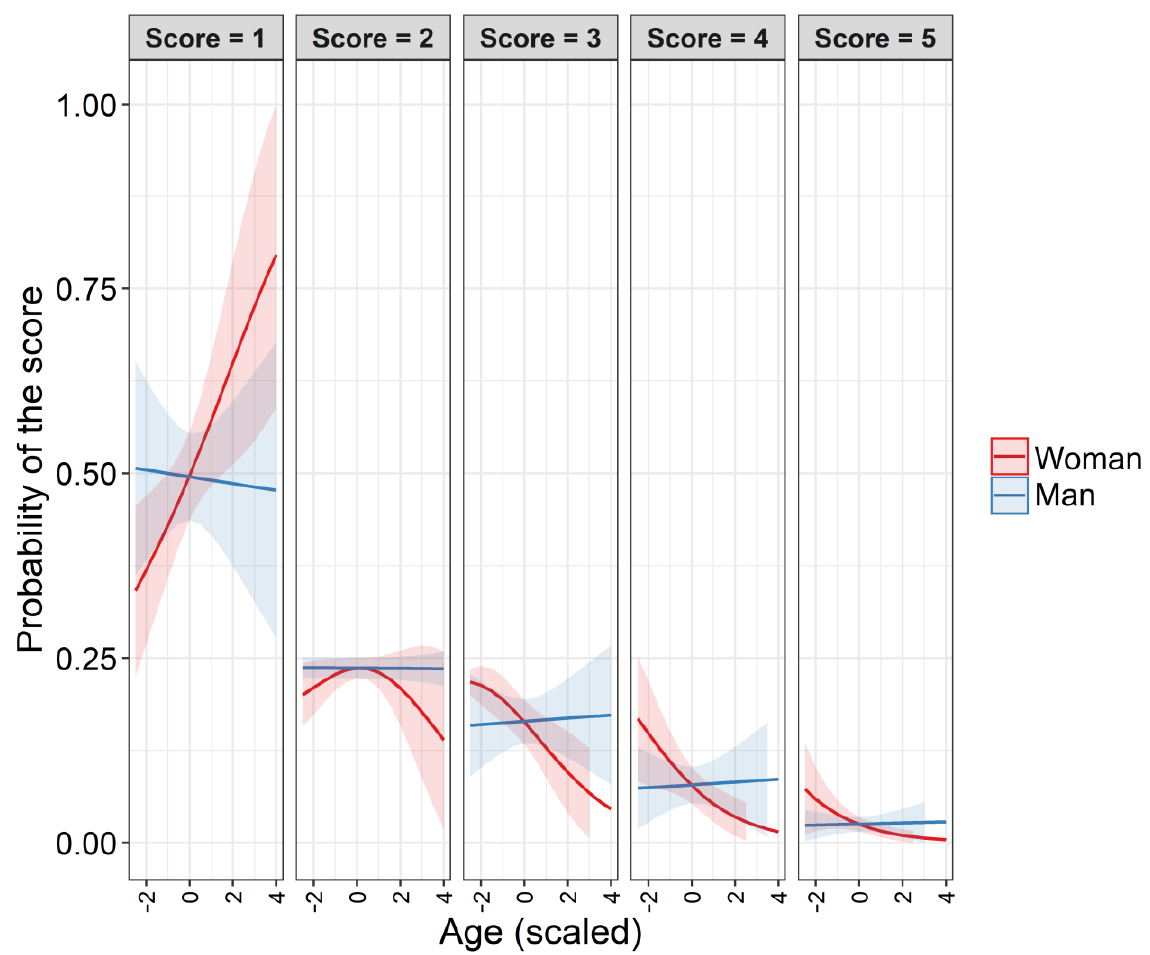
Figure 8. Predicted changes in the probability (lines) with 95% CI (ribbons along lines) of the different funniness scores in two genders across age. The results of the cumulative link mixed model are shown in Table 5. Different funniness scores are represented by the gray facet labels. The x -axis is scaled, with zero equaling 35.2 years ± 8.50 SD. Further explanations are presented in Figure 6.